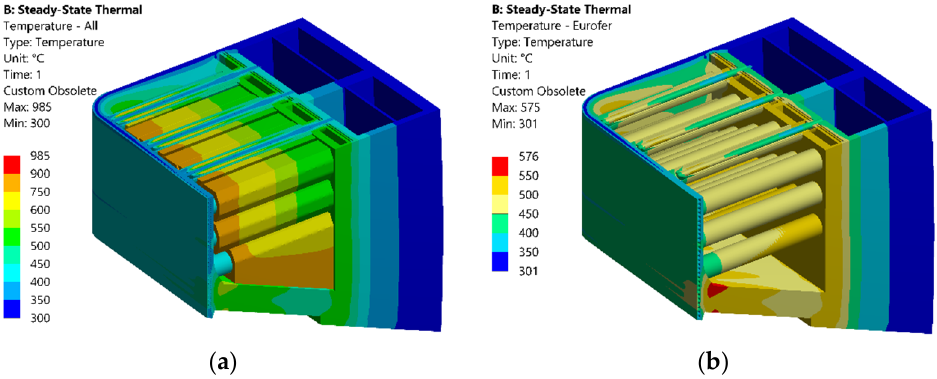
Figure 7. Temperature distribution ( a ) on the whole BB cap region, and ( b ) on Eurofer97 structures.